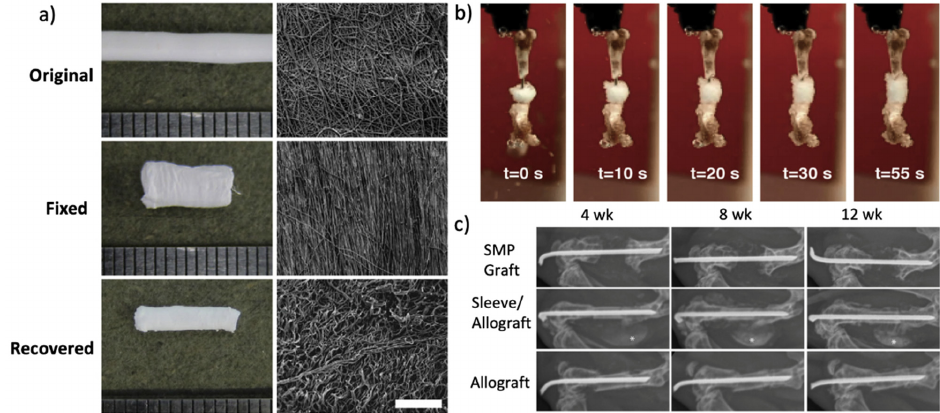
Figure 6. ( a ) Electrospun fibers were randomly oriented before fixing, aligned along the circumference, and randomly oriented again after recovery; ( b ) the SMP graft filled the femoral defect in 45 °C water; ( c ) radiographs of mice treated at 4, 8, and 12 weeks post-surgery (Reprinted with permission from ref. [153]. Copyright 2016 Elsevier).